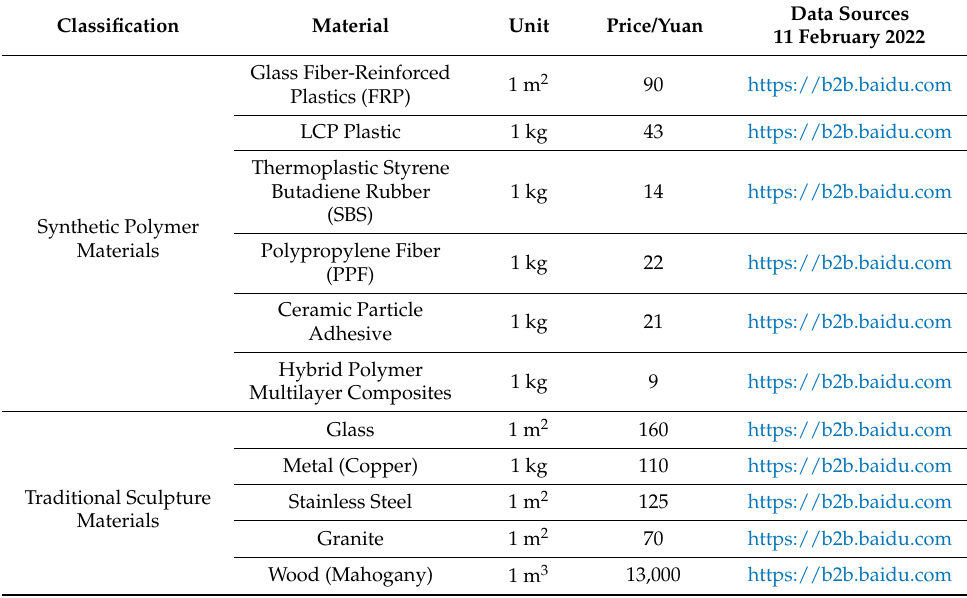
Table 4. Price comparison of some polymer materials and traditional sculpture materials.